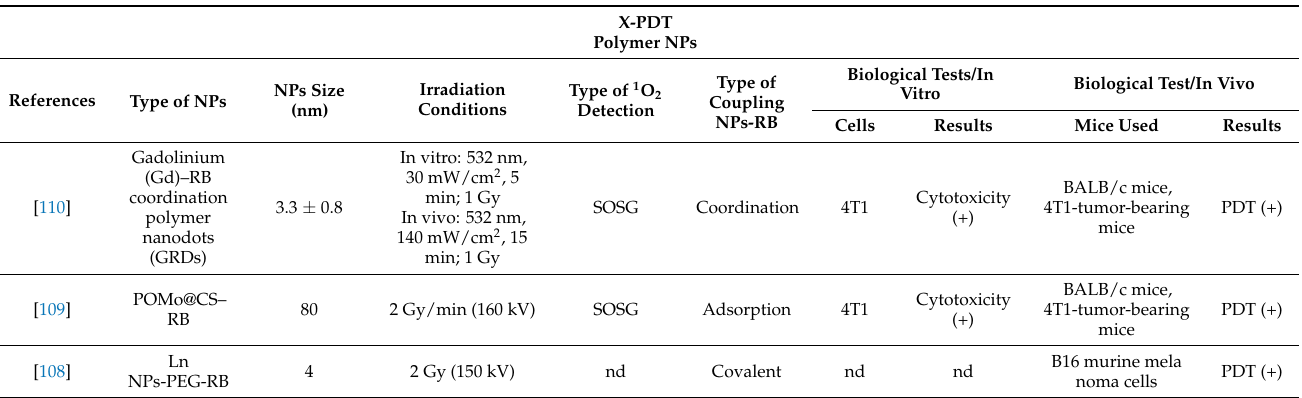
Table 8. References dealing with polymer NPs@RB under X-rays, including the type of NPs, along with their size, excitation wavelength, type of detection of 1 O 2 , the type of coupling between the NPs and the RB, and the type of biological tests performed.